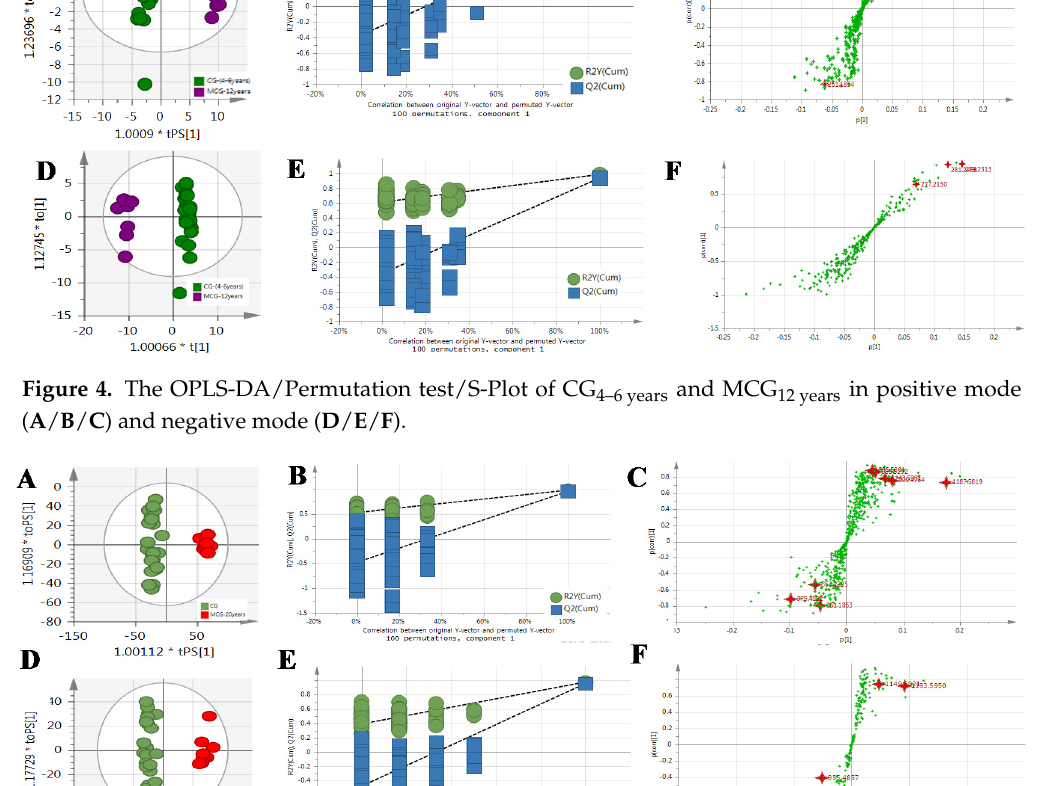
Figure 5. The OPLS-DA/Permutation test/S-Plot of CG 4–6 years and MCG 20 years. in positive mode ( A / B / C ) and negative mode ( D / E / F ).